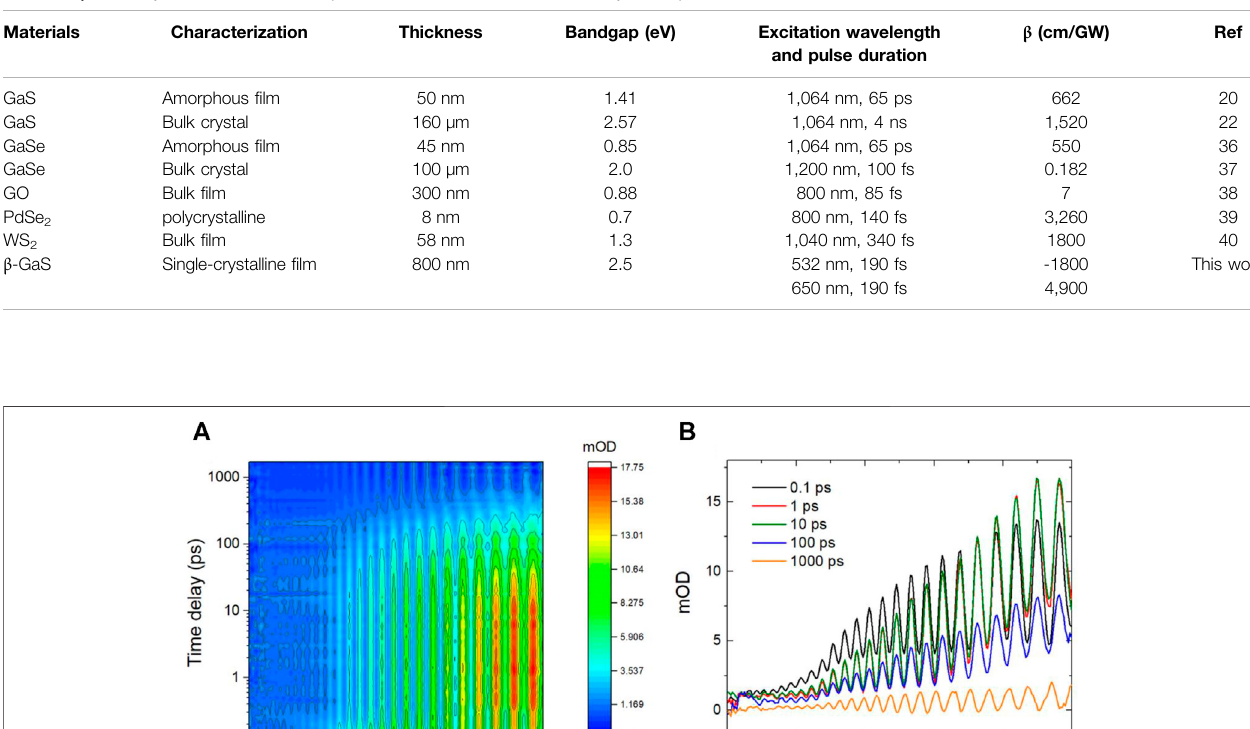
TABLE 1 | Summary of the nonlinear absorption coef fi cients obtained in this study and reported in recent literatures.